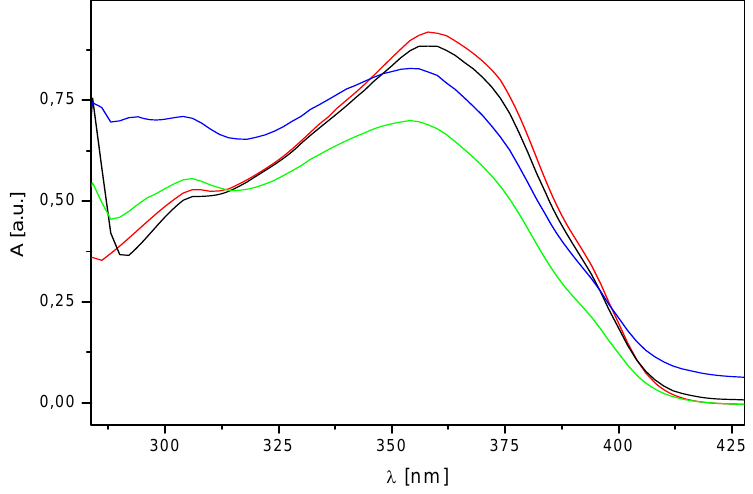
Figure 7. Absorption spectra of 4a in toluene (dissolution of 4a ( ⎯⎯ ), heating of solution to the boiling point of solvent ( ⎯⎯ ), irradiation with UV light (310 nm, t=15s, ⎯⎯ ), repeated heating of solution to the boiling point of solvent ( ⎯⎯ ).